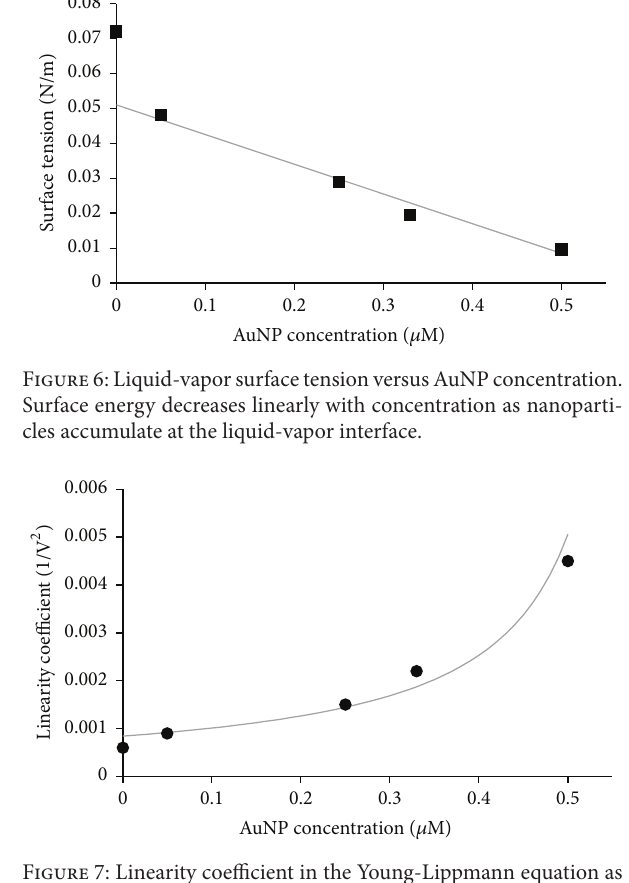
Figure 7: Linearity coefficient in the Young-Lippmann equation as a function of AuNP concentration. The theoretical curve is based on surface tension weakening as nanoparticle content